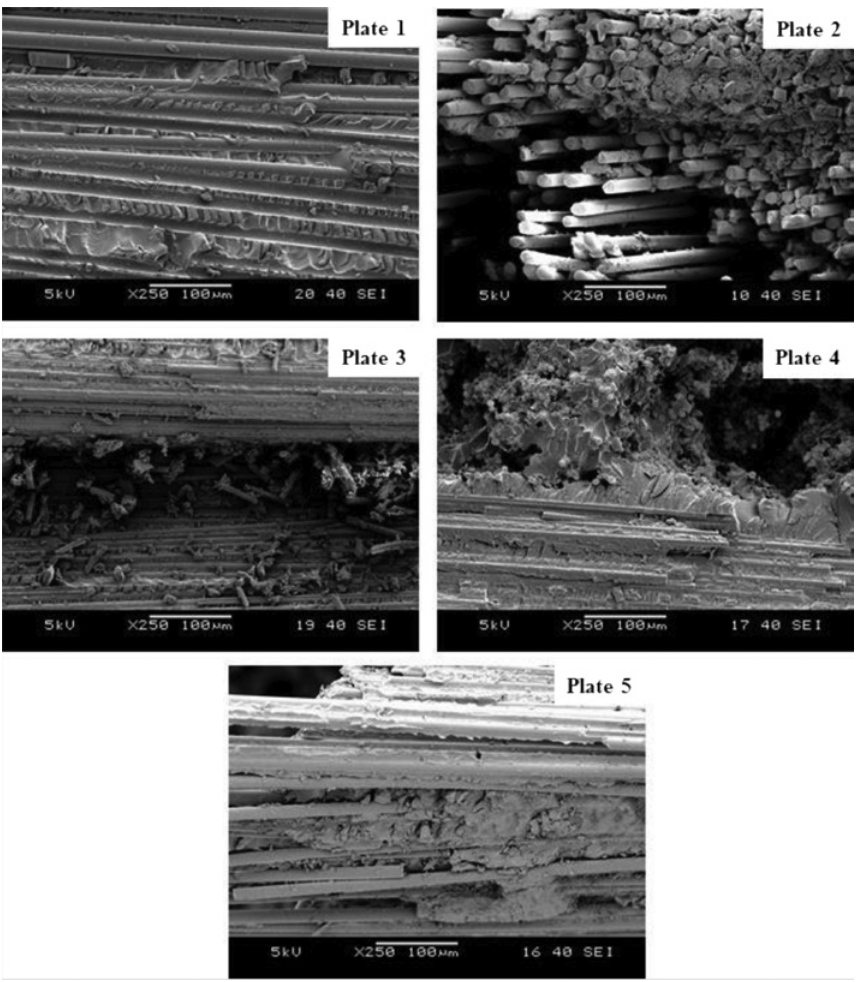
Figure 2: Scanning electron microscopic images of the tensile fracture surfaces of all manufactured composite